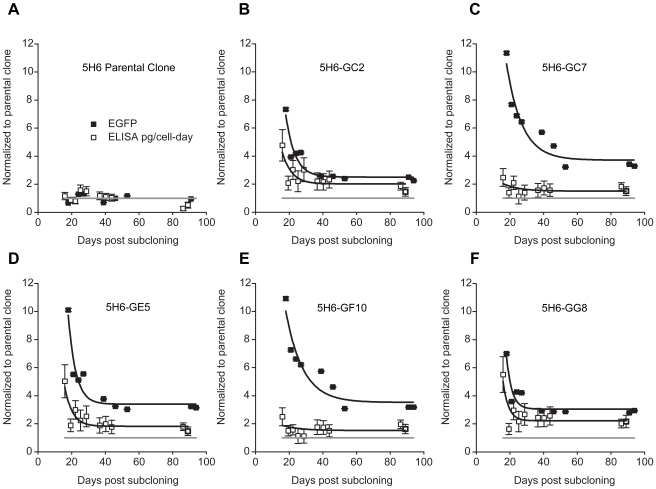
Dynamic response of high-expressing subclones.Five high-expressing subclones were isolated from parental clone 5H6 by stringent FACS sorting. First, the top fluorescing 0.05% of the double-positive population was sorted and recultured for 10 days. Then the top 0.05% of this enriched subpopulation was cloned by single cell deposition into a 96-well plate and the brightest five clonal colonies (5/26) were selected (overall stringency roughly 1 in 20,000,000). A control 96-well plate sorted from the center of the double-positive population yielded 50 clonal colonies, but none of comparable brightness to the selected subclones. Expression dynamics in the parental clone, A) and the five chosen subclones, B–F), were monitored during long-term culture (in the presence of selection) by flow cytometry (median EGFP fluorescence, closed symbols) and ELISA (cell specific antibody secretion rate, pg/cell-day, open symbols). Data is presented in terms of double positive cells, normalized to the parental clone, and fitted to a first order exponential decay (lines). See Methods for details. Horizontal gray lines indicate the level of the parental clone (normalized expression = 1). Error bars are standard errors.  for subclones 5H6-GC2, -GC7, -GE5, -GF10, and -GG8 were 4 days (∼4 generations), 6 days (∼7 generations), 3 days (∼4 generations), 7 days (∼7 generations) and 2 days (∼2 generations), respectively. EYFP similar (not shown).